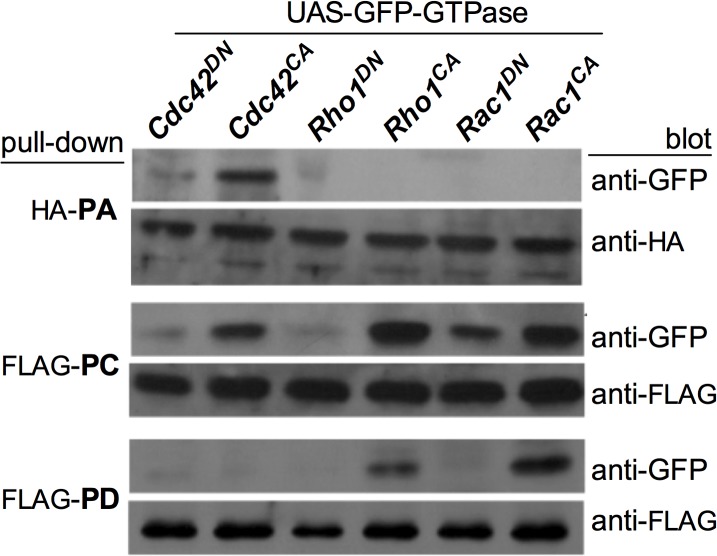
RhoGAP18B isoforms bind different members of the Rho-family of GTPases.Co-immunoprecipitation blots showing pull-down of GFP-tagged Rho-type GTPases with FLAG-tagged PC, FLAG-tagged PD, or HA-tagged PA. Rho-type GTPases pulled down with anti- FLAG or anti-HA beads was then detected with anti-GFP antibody. All isoforms preferentially bind to the constitutive active forms of Rho-family GTPases. PA binds to Cdc42 only; PD binds Rac1 and, to a lesser extent, Rho; and PC binds to all three GTPases. Representative blots from one of 3–5 independent experiments are shown.